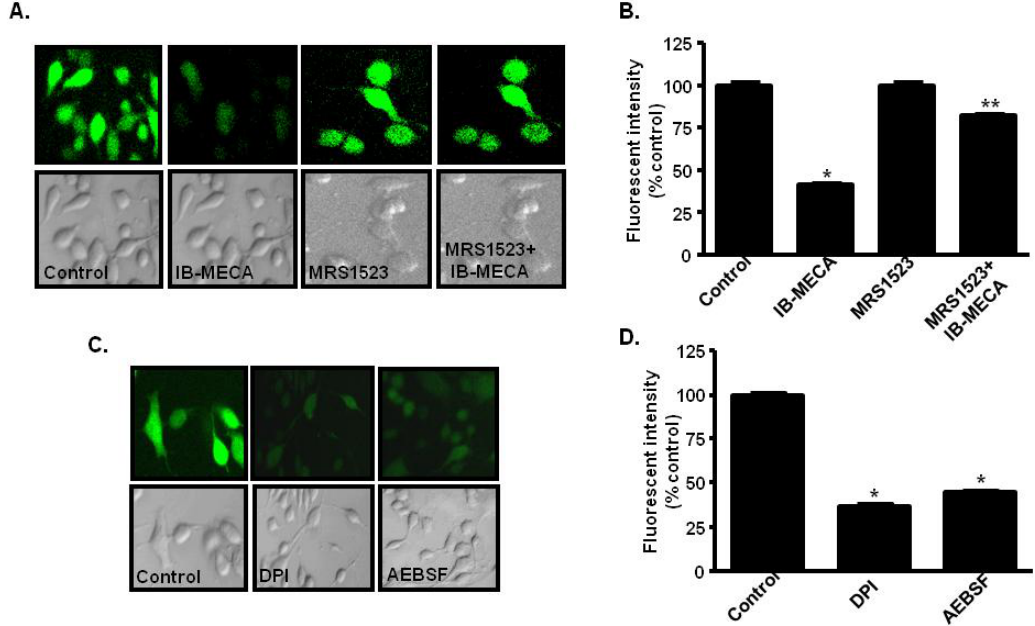
Figure 3. Activation of A AR suppresses ROS generation in AT6.1 prostate cancer cells. 3 Cells were pretreated with the A AR agonist, IB-MECA, the antagonist, MRS1523, or a 3 DCFDA fluorescence. combination of IB-MECA + MRS1523. ROS was determined by H 2 IB-MECA significantly reduced fluorescence in these cells ( A , B ) which was reversed by MRS1523, indicating a role of the A AR in this process. Similar effects were obtained with 3 DPI and AEBS F , known inhibitors of NADPH oxidase ( C , D ). Experiments were replicated four times. Histograms represent the mean ± SEM. Asterisks ( * ) and ( ** ) indicates statistically significant difference ( p < 0.05) from vehicle and IB-MECA treatments, respectively. (Reprinted with permission from [169], Copyright 2009 Neoplasia Press,